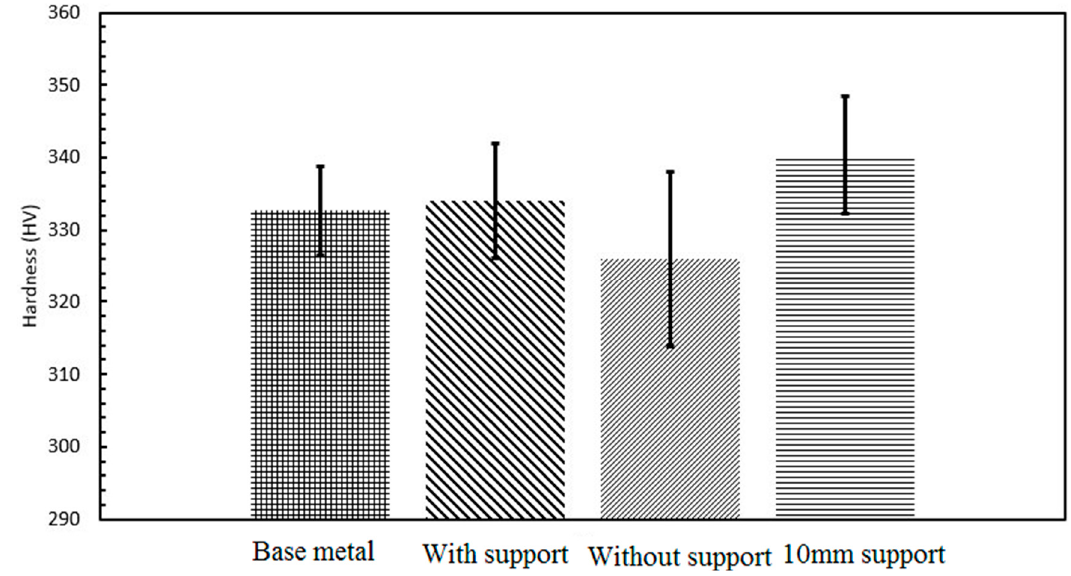
Figure 20. 30-mm-diameter and 5-mm-thick samples.